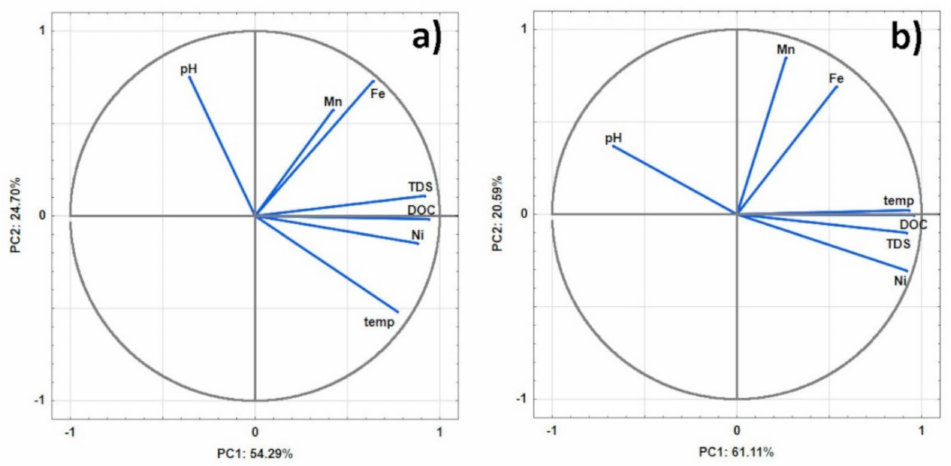
Figure 6. Correlations between the variables and principal components in the projection of PC1 and PC2 for ( a ) 2018 and ( b )